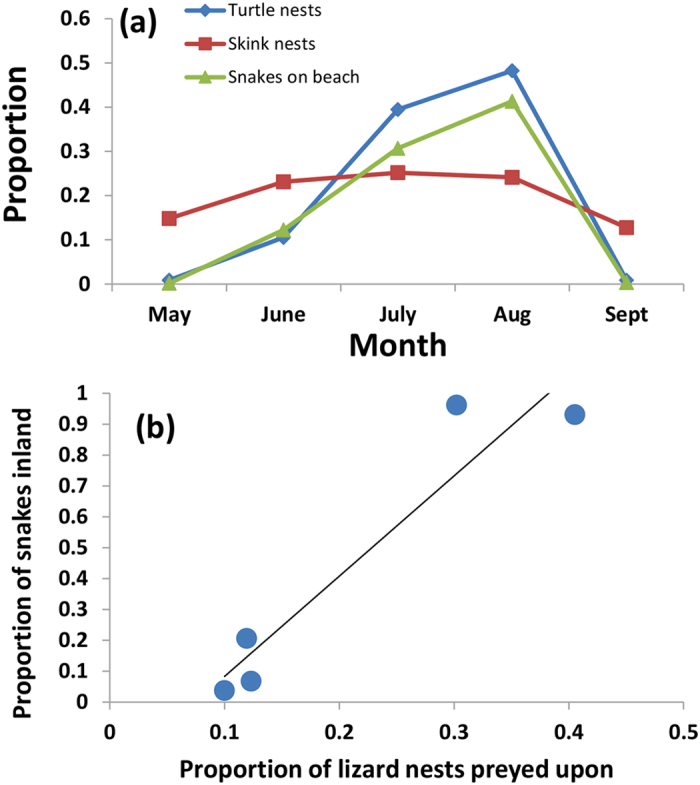
Seasonal patterns of nesting activity and nest predation on Orchid Island, Taiwan.Sea turtle nesting is highly seasonal and coincides with egg-eating snake abundances at the beach, whereas lizard nesting occurred in each month ((a) n = 5). Proportions represent the number of monthly observations as a function of the total number. In May and September, >99% of snakes are inland, at the lizard nesting site. Predation rates of lizard nests are highest when proportionately more snakes are inland (b).